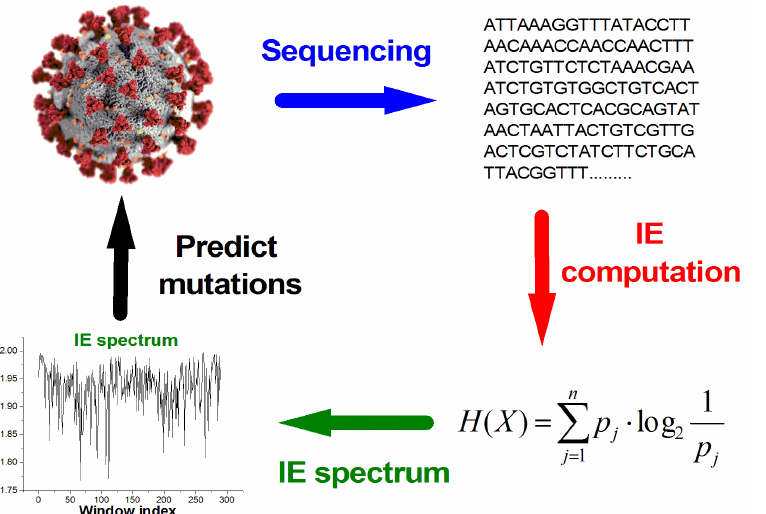
Figure 3. Diagrammatic representation of the methodology to produce the IE spectrum in order to facilitate studies of possible predictive algorithms of future genetic mutations.